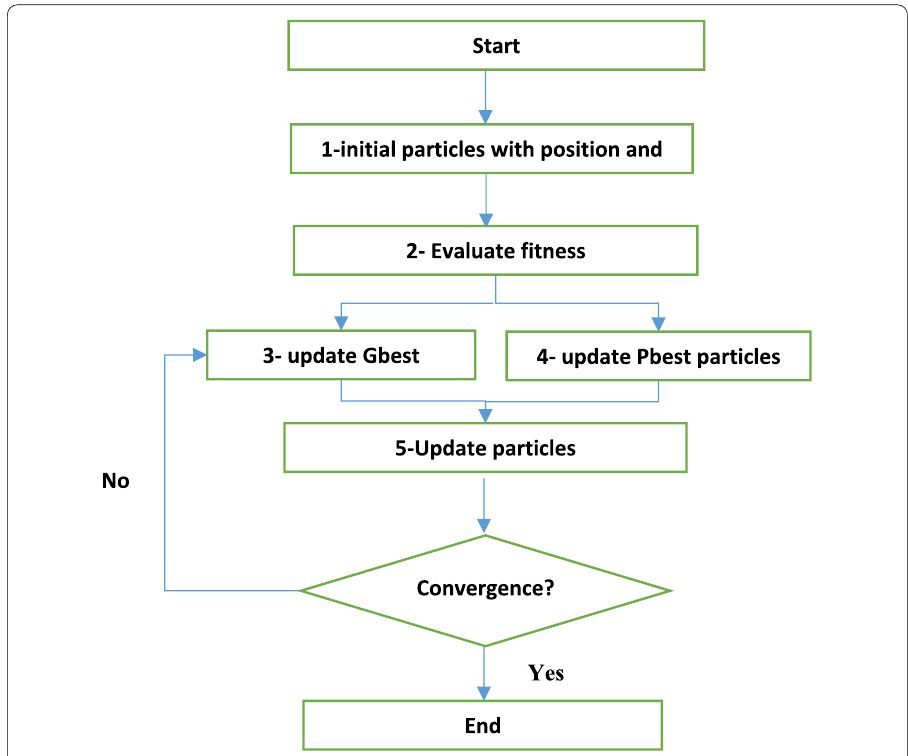
Fig. 4 Standard particle swarm optimization flow